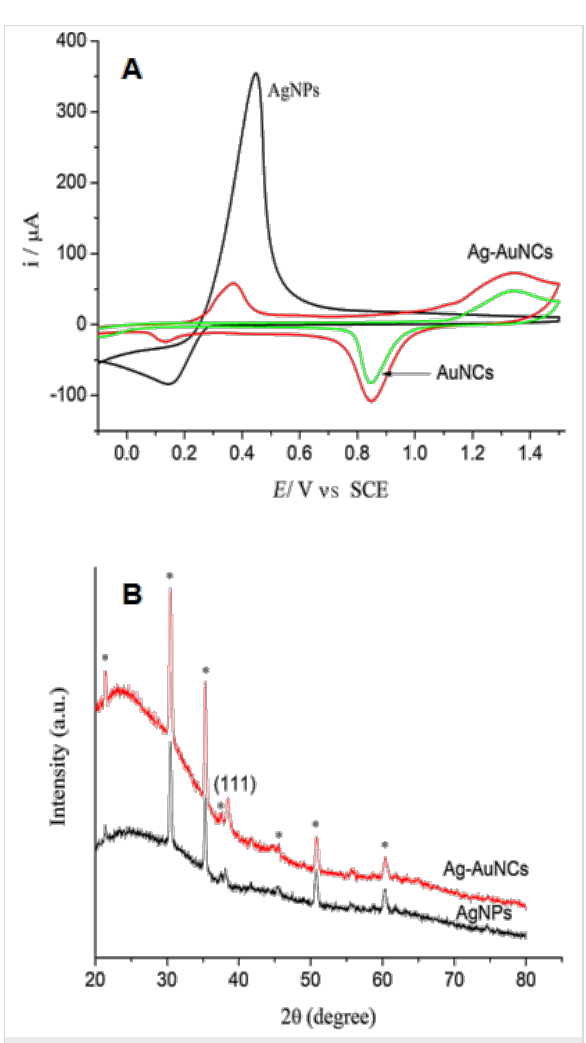
Figure 4: (A) Cyclic voltammograms of ITO-supported Ag NPs, Ag–Au NCs before and after (AuNCs) dealloying in 10% HNO 3 solution for 10 h; (B) XRD patterns of ITO-supported Ag NPs before and after galvanic replacement reactions (* indicates the peaks of ITO).